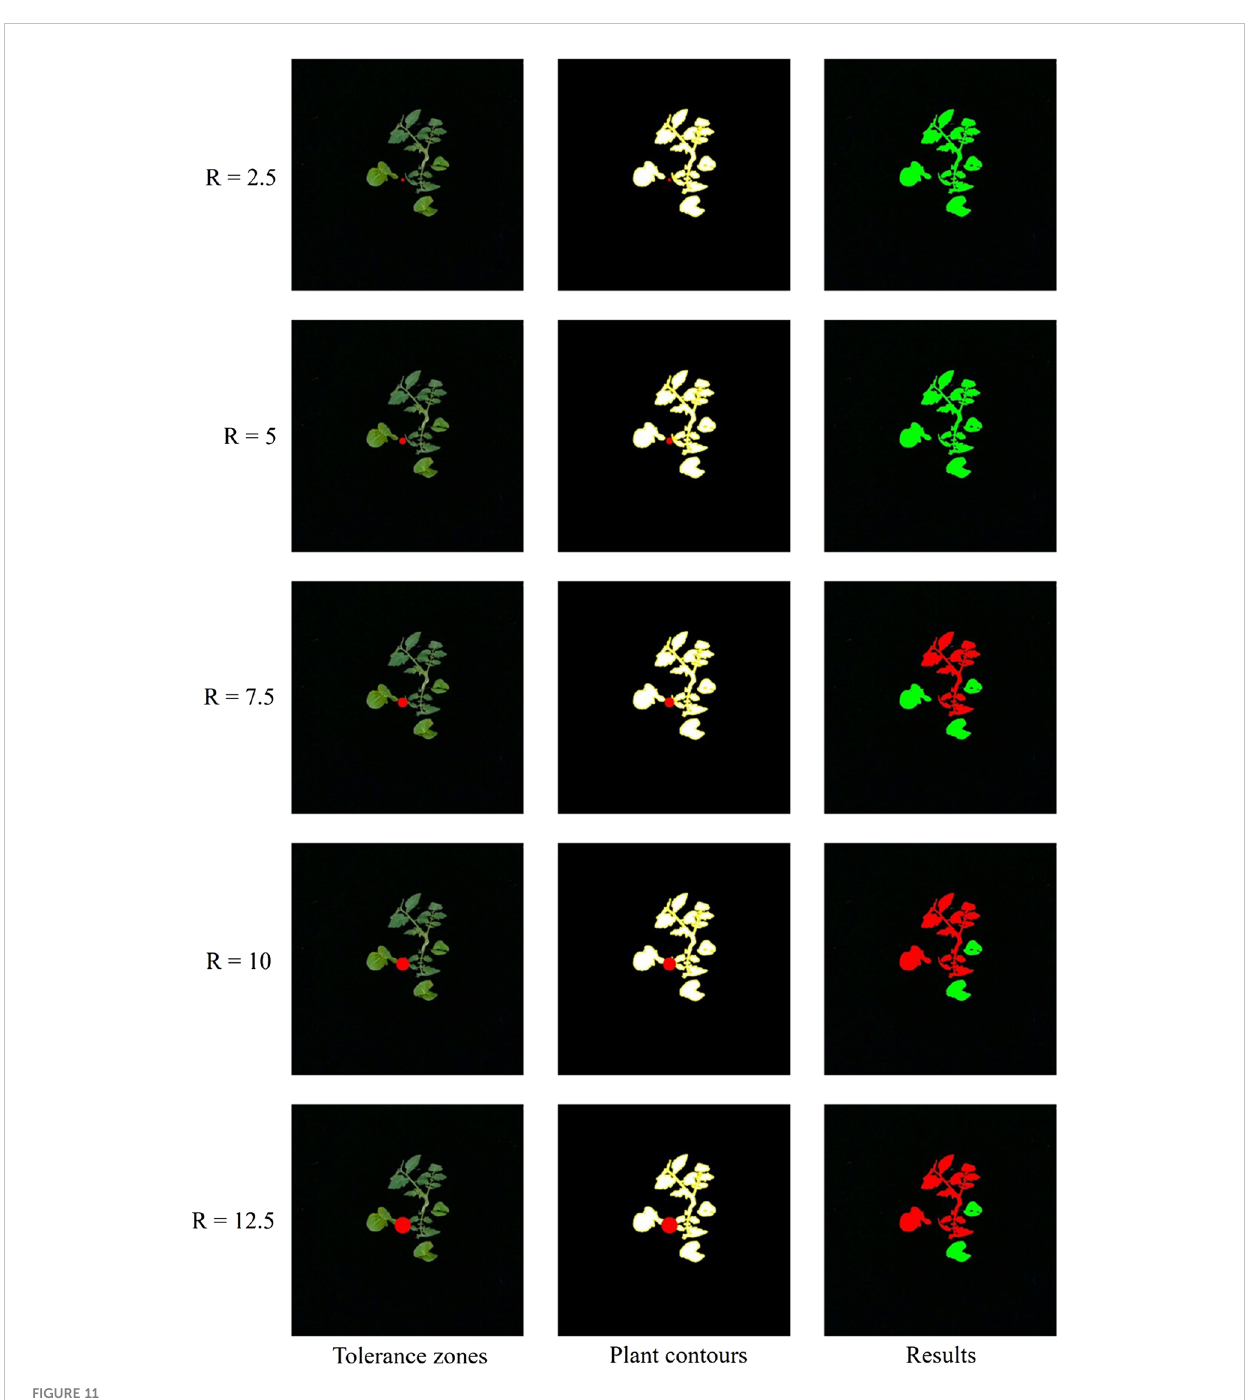
FIGURE 11 Five sizes of circular tolerance zones (red